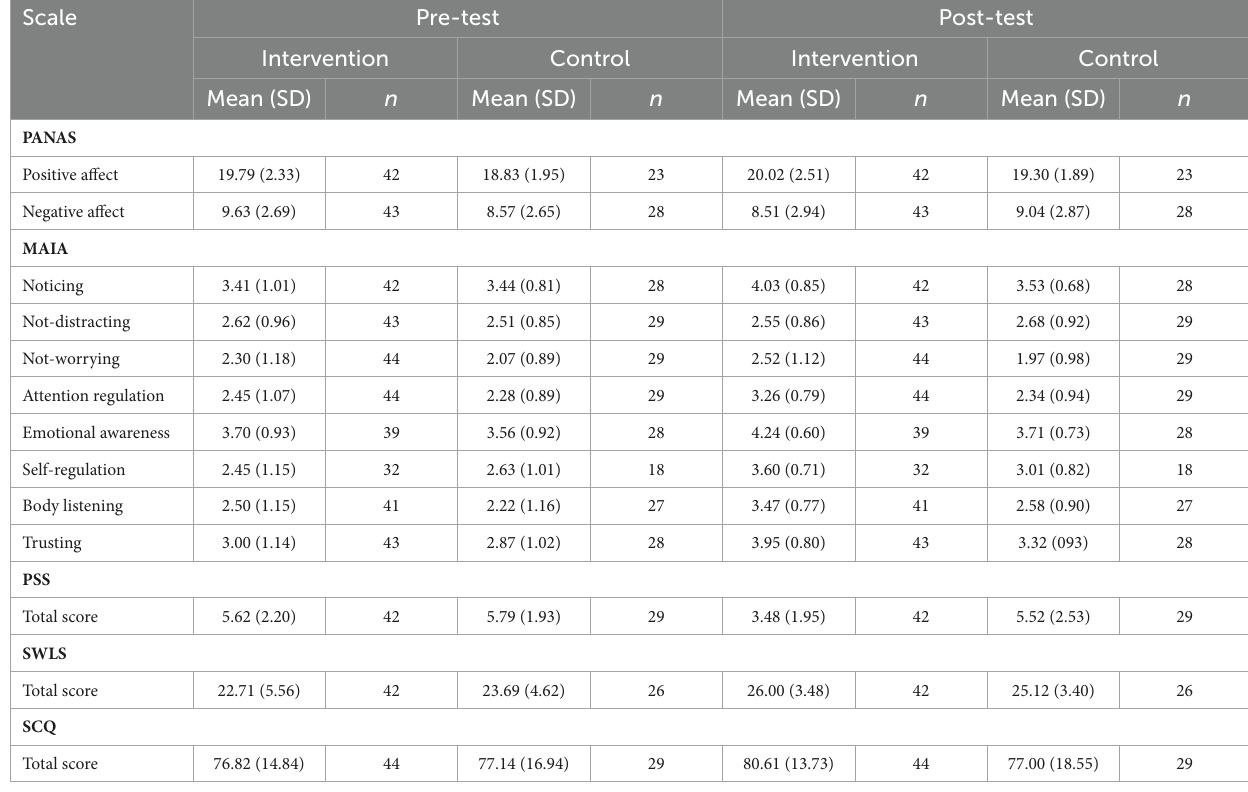
TABLE 1 Descriptive statistics of the assessed variables before and after the intervention. Scale Pre-test Post-test Intervention Control